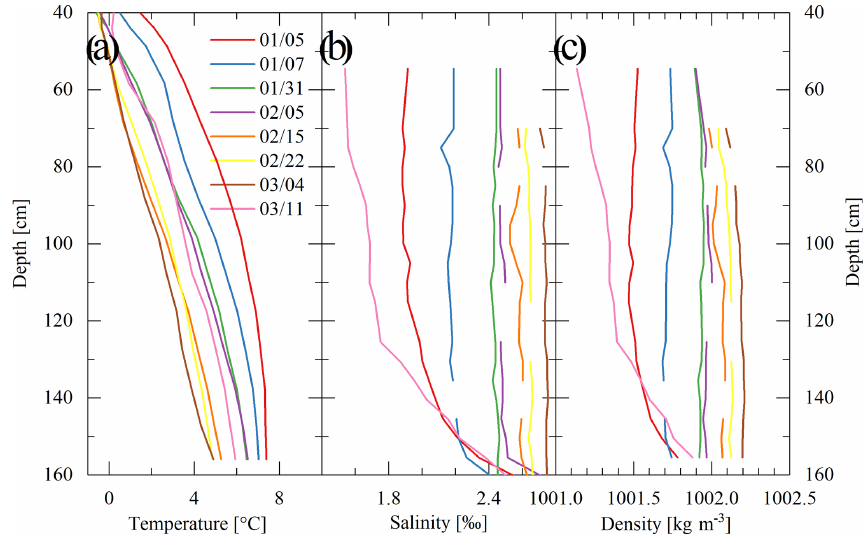
Figure 6. Observed temperature and salinity profiles and estimated water density (according to Leppäranta, 2015) in winter 2017.